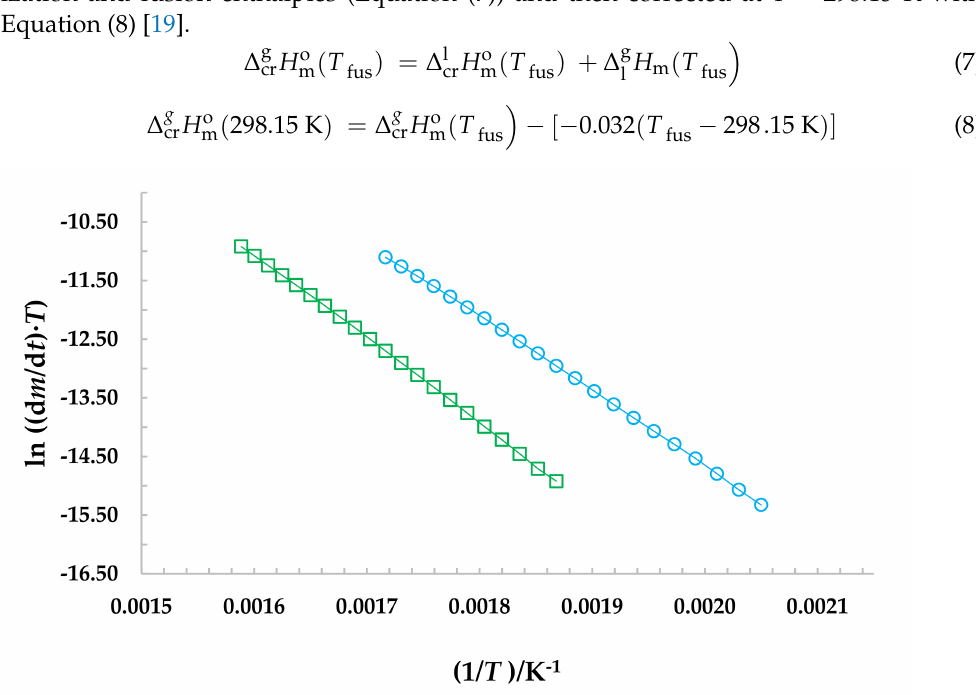
Figure 2. Representative dependence of ln (( d m /d t ) · T ) versus 1/ T of each compound. (cid:3) 1,3-bis( N - carbazolyl)benzene (NCB); 1,4-bis(diphenylamino)benzene (DAB). (cid:35)